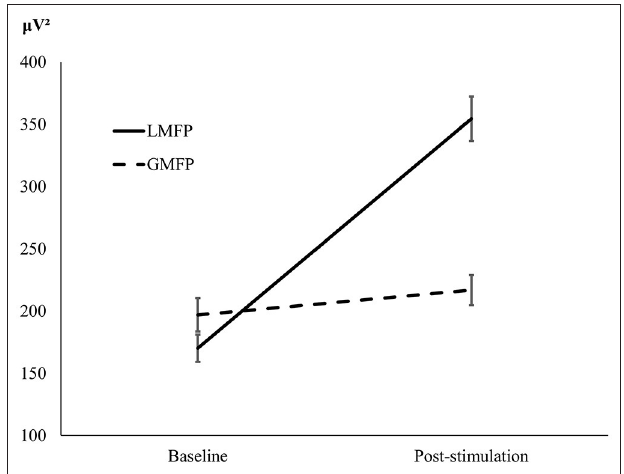
FIGURE 1 | L-PFC. Graphical representation of local (LMFP) and global (GMFP) reactivity, at baseline and after stimulation.